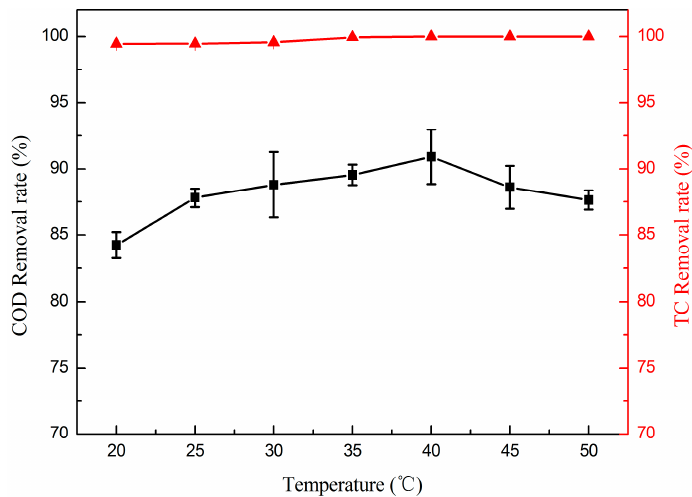
Figure 5. Effect of temperature on the removal rate of TC ( ▲ ) and COD ( ■ ). ( TC = 50 mg·L − 1 , RT = 4.4 min and j = 1 mA·cm − 2 ).